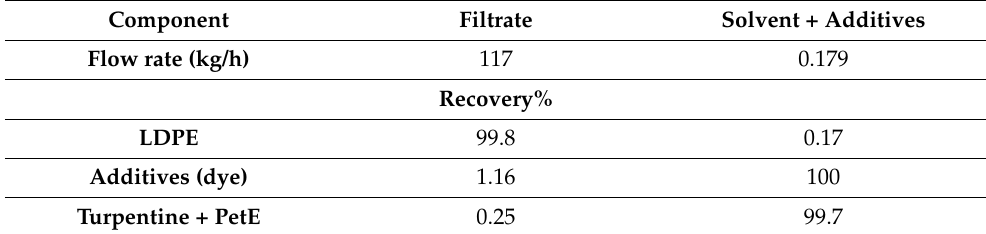
Table 7. Mass recovery rates obtained from the simulation